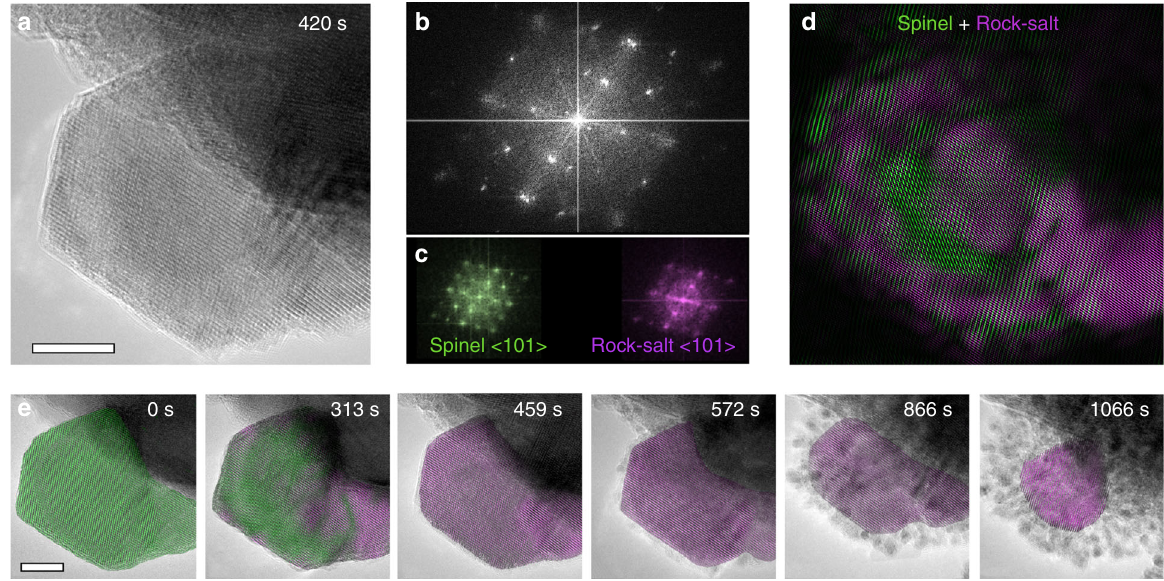
Fig. 3 Two-phase transformation mechanism probed via in situ HRTEM imaging. a HRTEM image of partially reacted L-ZFO obtained at 420 s (scale bar: 10 nm) and b the corresponding FFT pattern. c Two sets of FFT patterns extracted from b representing coexistence of spinel (green) and ordered rock-salt phase (magenta). d Inverse FFT image shows the distribution of spinel (green) and ordered rock-salt phase (magenta) in real space. e Time-sequenced HRTEM images with phase information (false-color) showing the transformation pathway of L-ZFO as a function of reaction time. Scale bar: 10